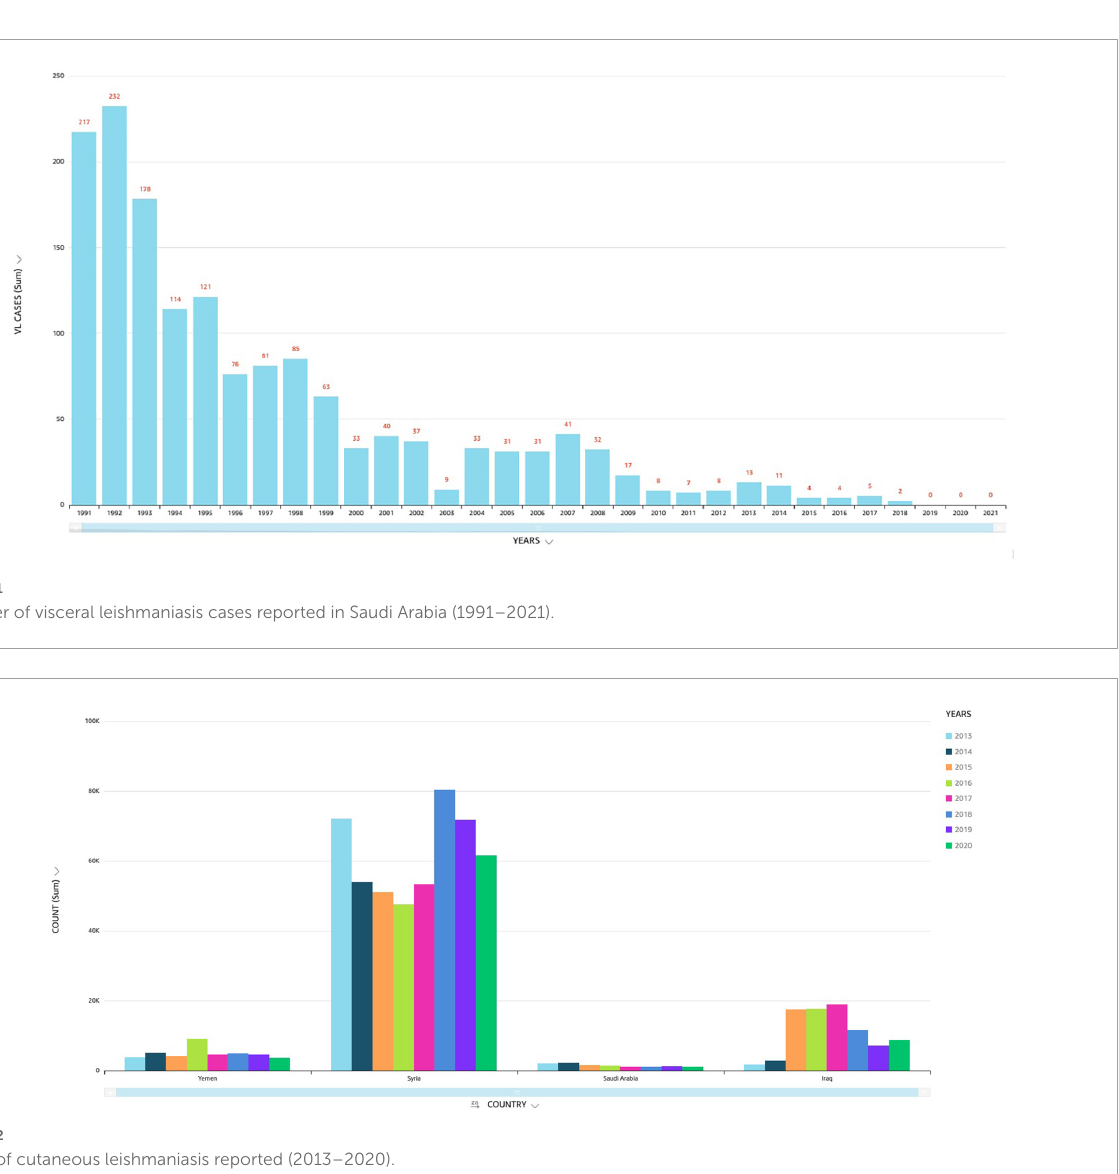
FIGURE2 Cases of cutaneous leishmaniasis reported